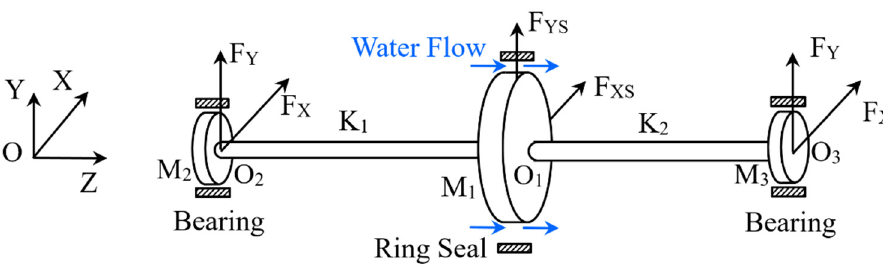
Figure 9. Model of the rotor-bearing-seal system.